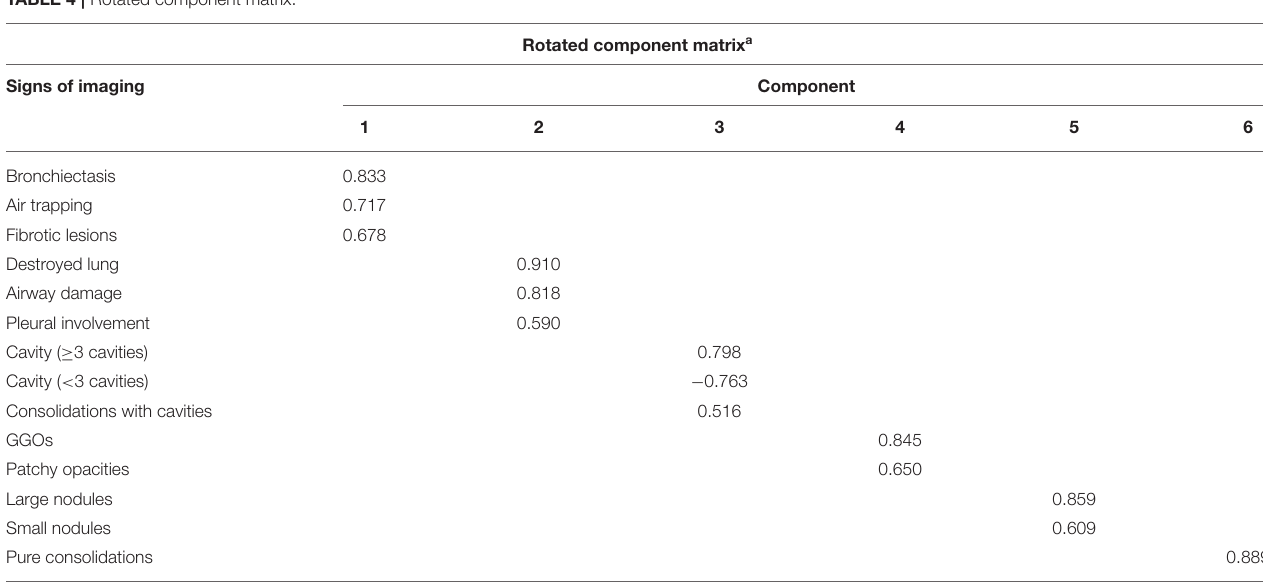
TABLE 4 | Rotated component